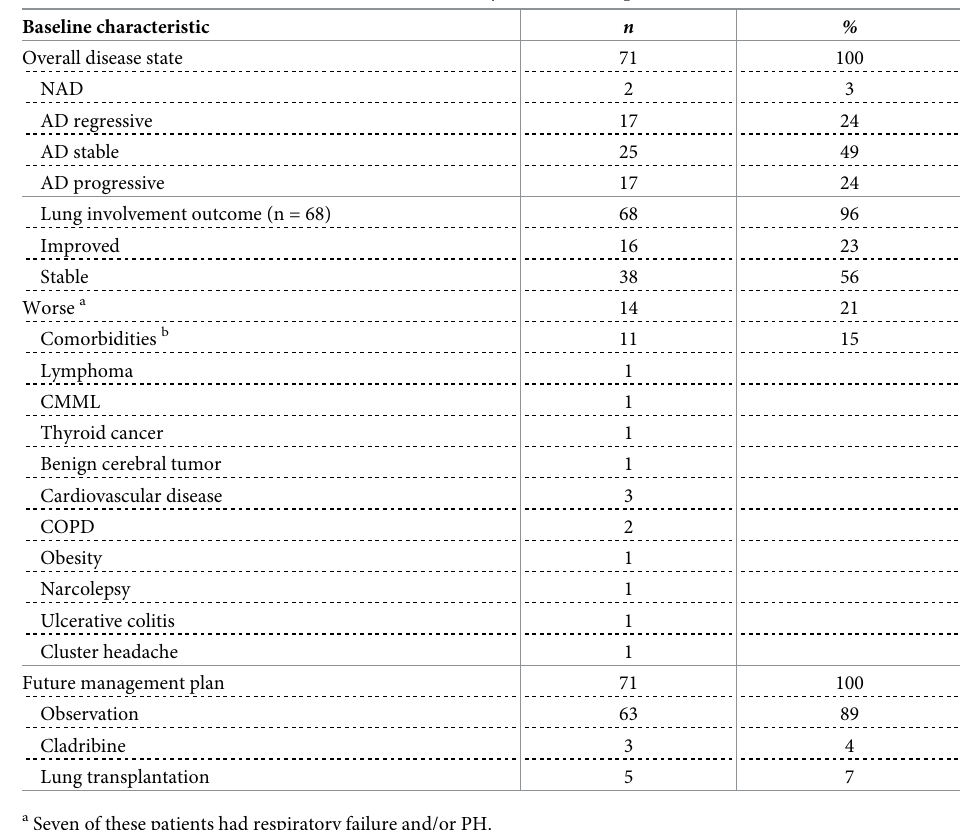
Abbreviations : Same as Table 1 plus AD: Active disease, CMML: Chronic myelomonocytic leukemia, COPD: Chronic obstructive pulmonary disease, NAD: Nonactive